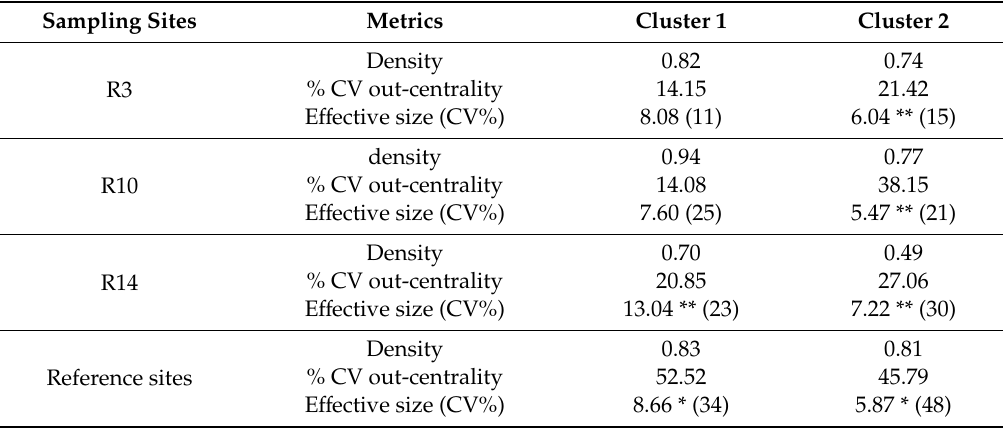
Table 4. Means of density and e ff ective size recorded in the first two clusters of ecological equivalence (descending average density). Coe ffi cients of variation (CV%) for out-centrality and e ff ective size are also shown. Significant di ff erences in comparison to corresponding average estimations made in 999 random networks with the same number of links are shown by stars: ** p < 0.01, * p <